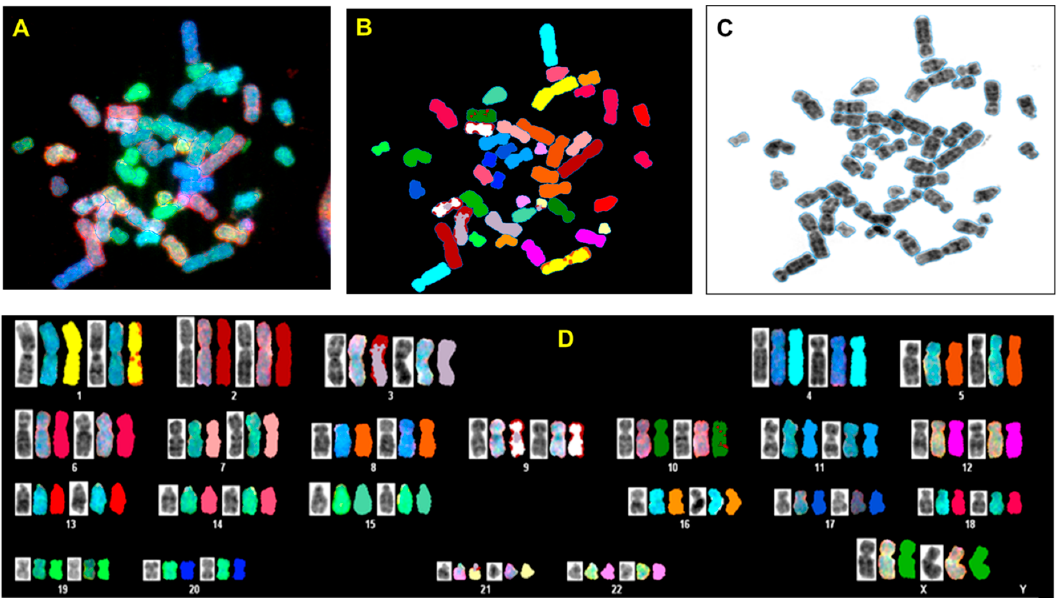
Figure 4. Spectral karyotyping (SKY) of representative metaphase from normal breast cell (HMECs). The SKY was performed as described (Materials and methods). ( A ) metaphase spread: raw image; ( B ) Metaphase spread: spectral image; ( C ) metaphase: inverted DAPI image, ( D ) classified spectral karyotype of the identical metaphase. SKY was performed in three independent experiments as described in the Materials and Methods. A minimum of 20 metaphases was analyzed per experiment.